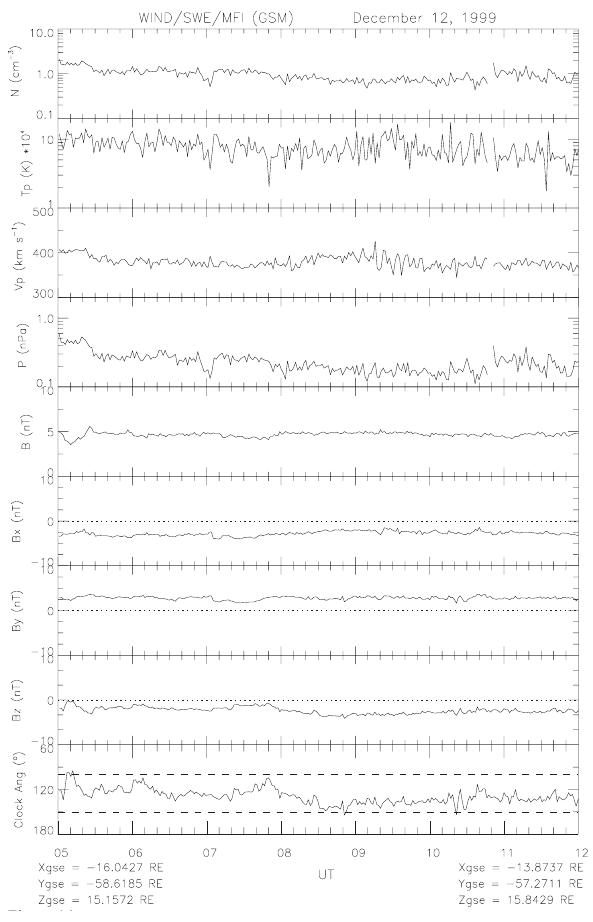
Fig. 14. Solar wind plasma and IMF observations from spacecraft Wind during the interval 05:00–12:00 UT on 12 December 1999. Panels from top to bottom shows proton density, bulk speed, tem- perature, solar wind dynamic pressure, the total field intensity and the GSM components ( B x , B y , and B z ) of the interplanetary mag- netic field (IMF), and the clock angle in the GSM Y − Z plane.